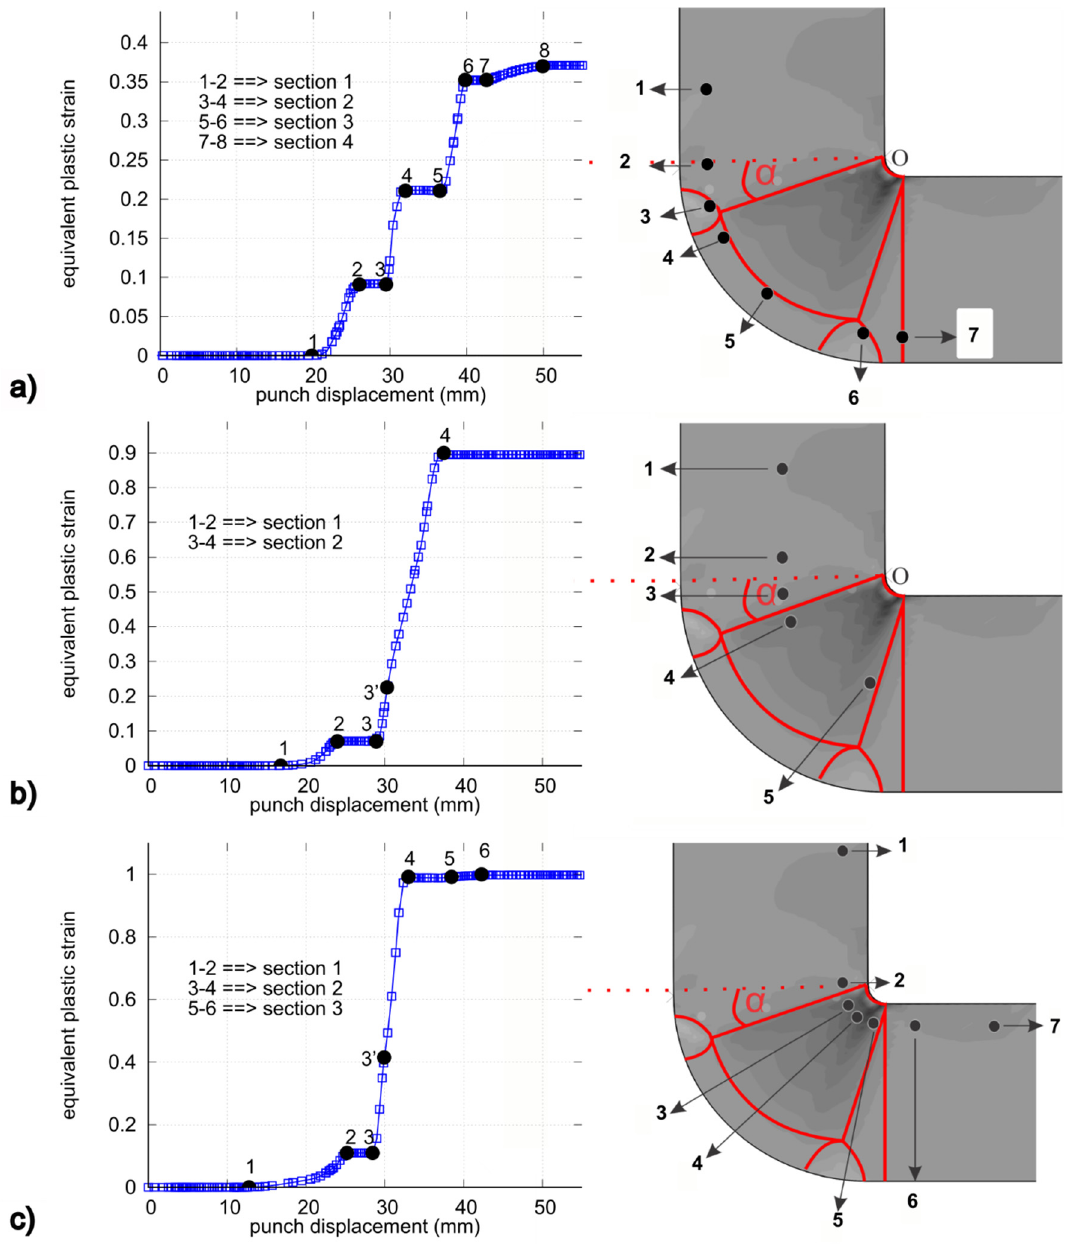
Figure 9. Evolution of the equivalent plastic strain as a function of the punch displacement: ( a ) point 4; ( b ) point 11; ( c ) point 18.